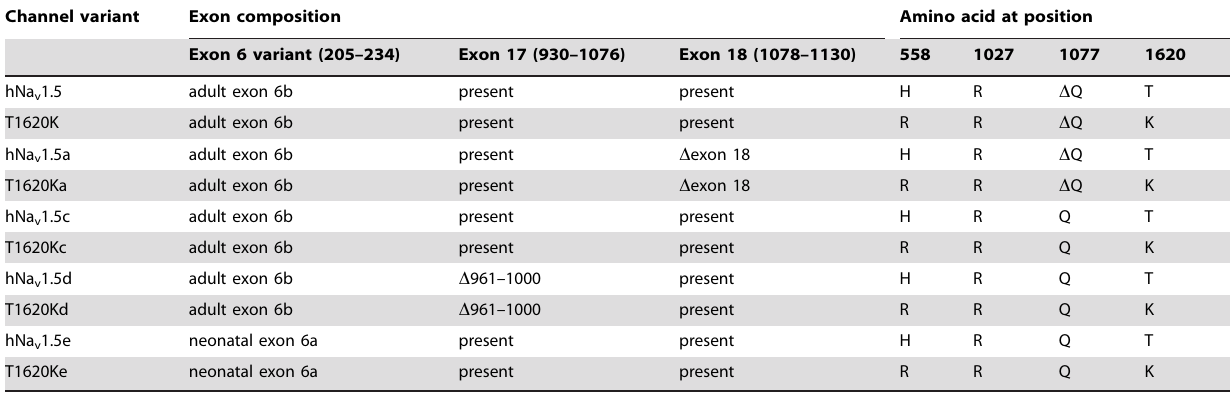
Channel variant